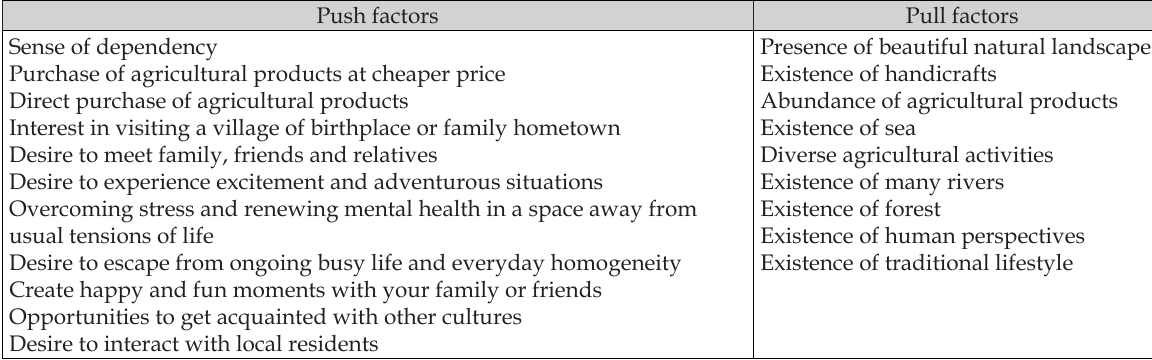
Table 1. Push and pull motivational